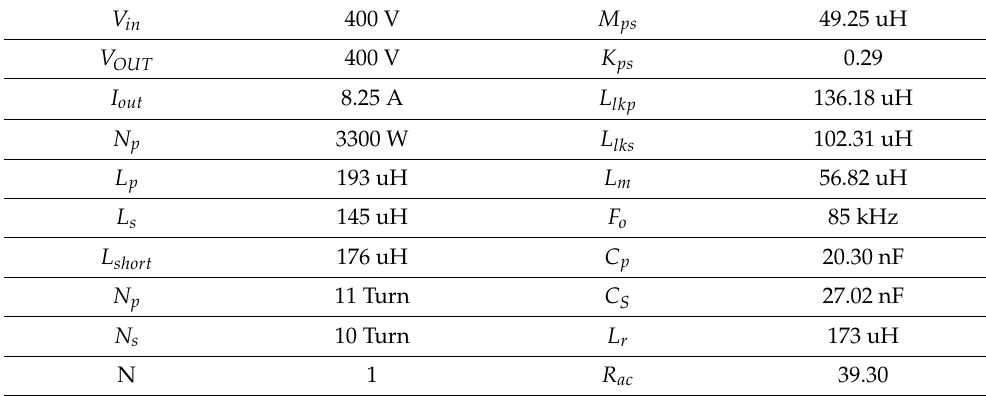
Table 2. Design specifications of the wireless power transfer system for the experiment.